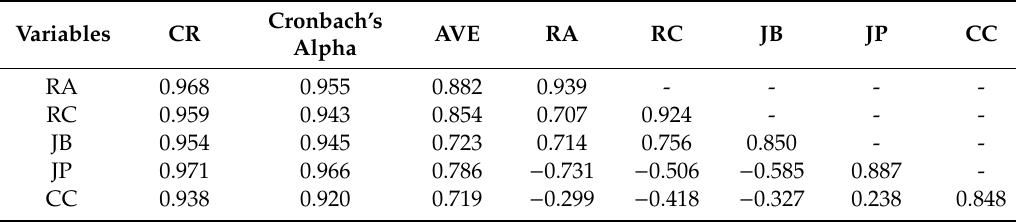
Table 3. The reliability and validity of